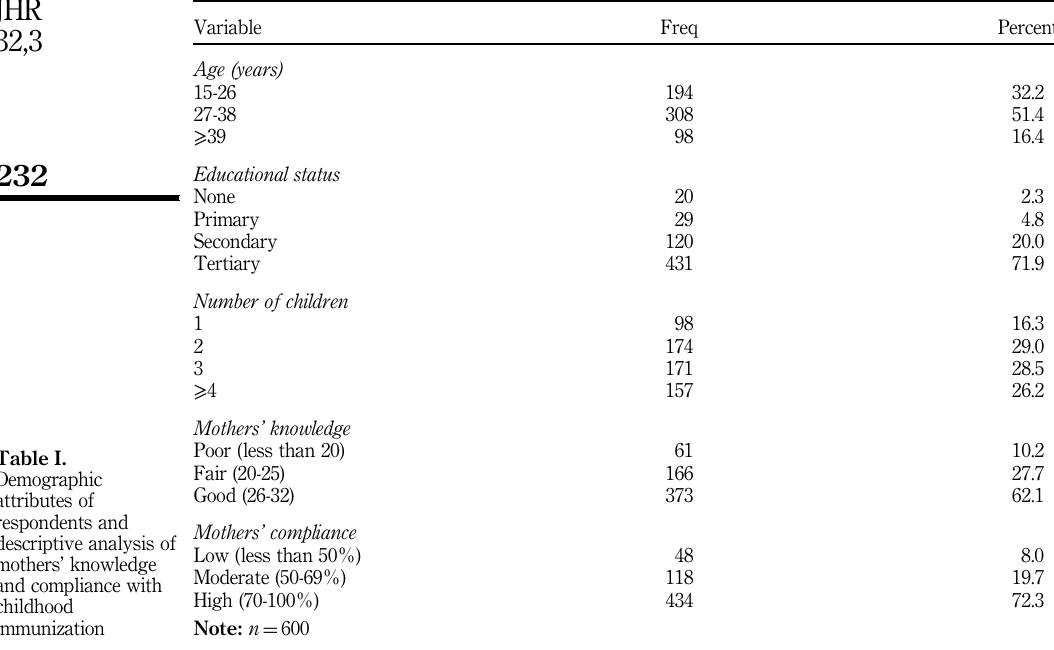
attributes of respondents and descriptive analysis of mothers ’ knowledge and compliance with childhood